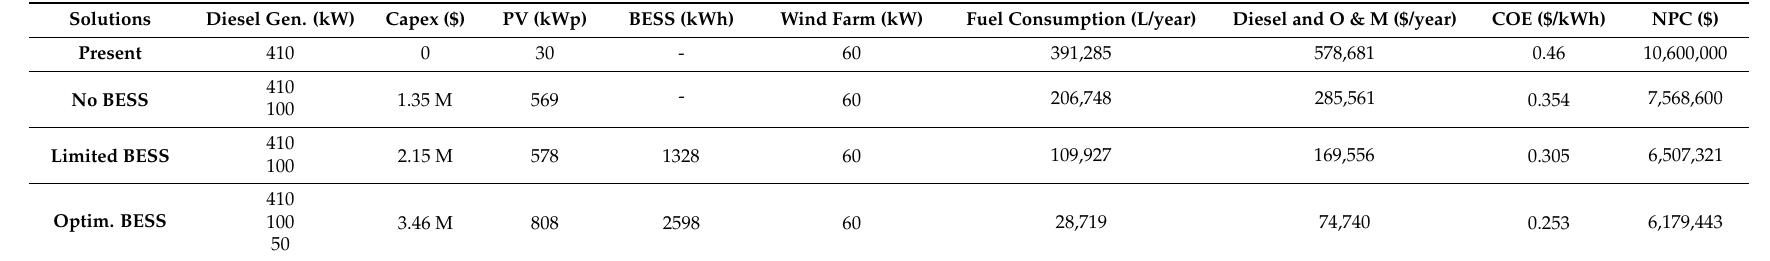
Table 4. Comparison of the economics of the different